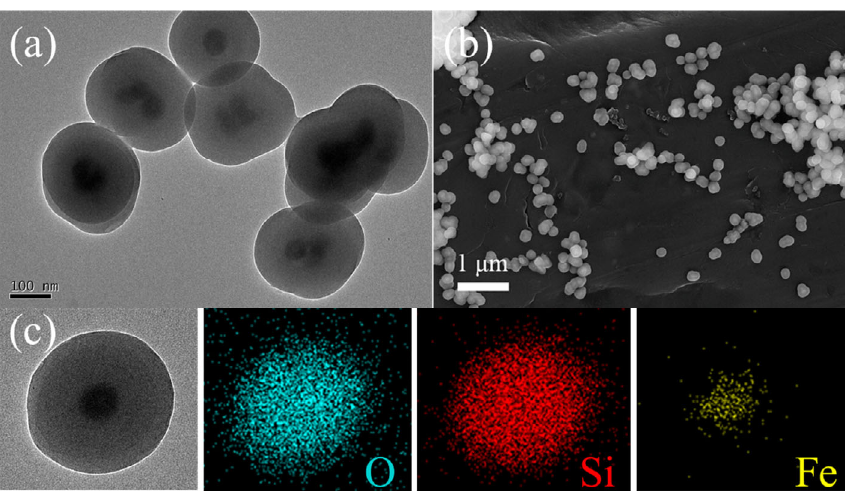
Fig. 6 (a) TEM and (b) SEM images of the α-Fe 2 O 3 @SiO 2 pigments with the shell thickness of 60 nm after calcination at 1000 ℃ ; (c) EDS mapping of the samples.